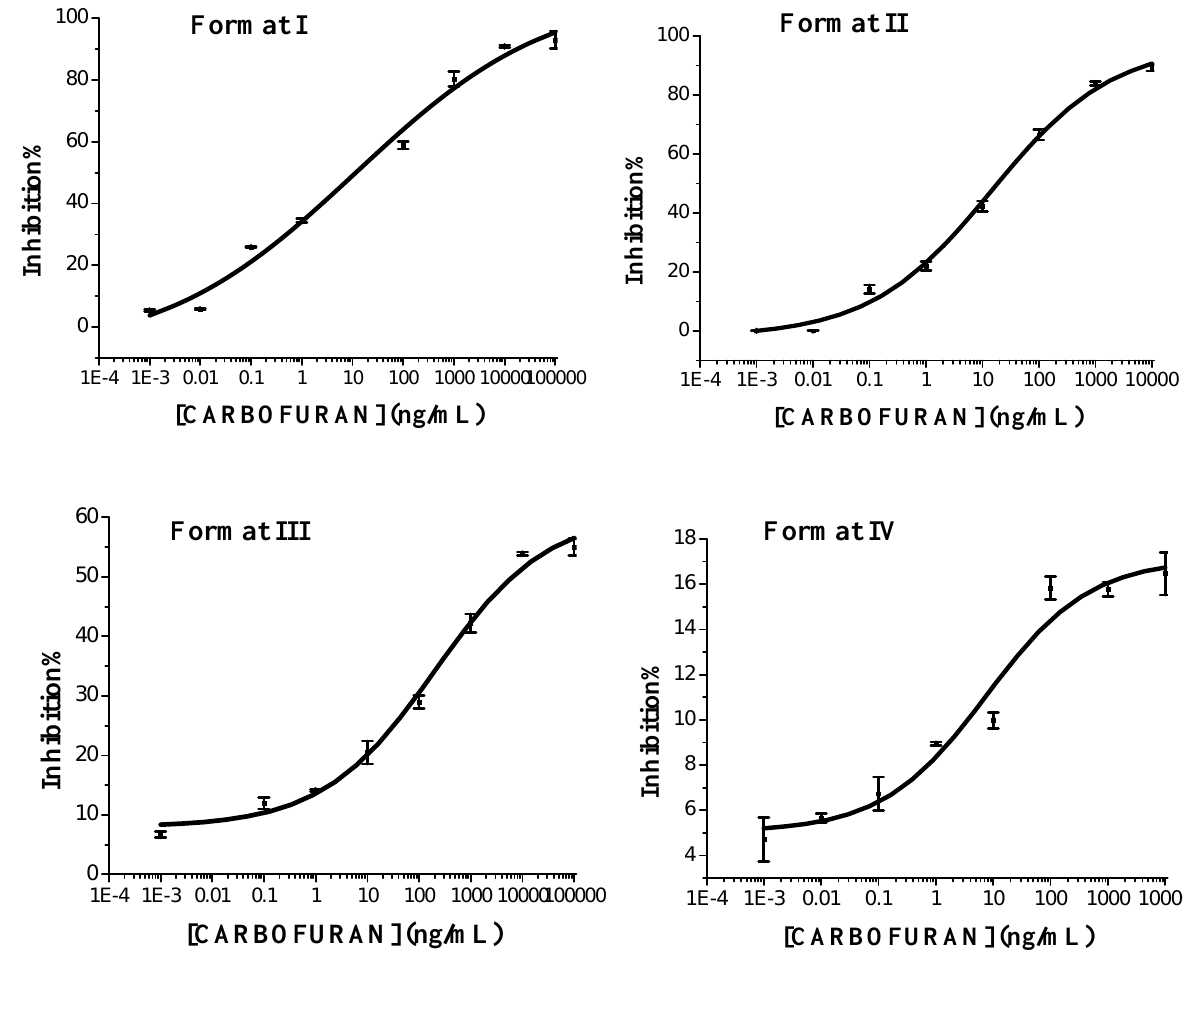
Figure 1 . Carbofuran inhibition curves using the four test